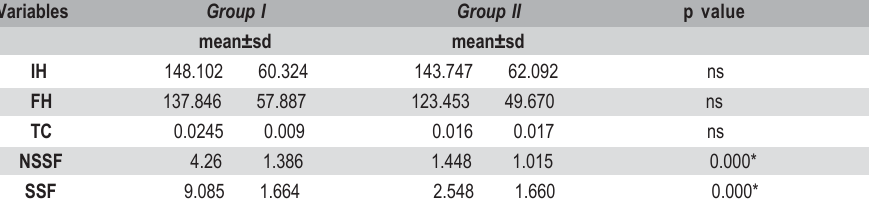
Table 1 - Mean (SD) obtained for the variables IH, FH, TC, NSSF and SSF in Groups I and II.